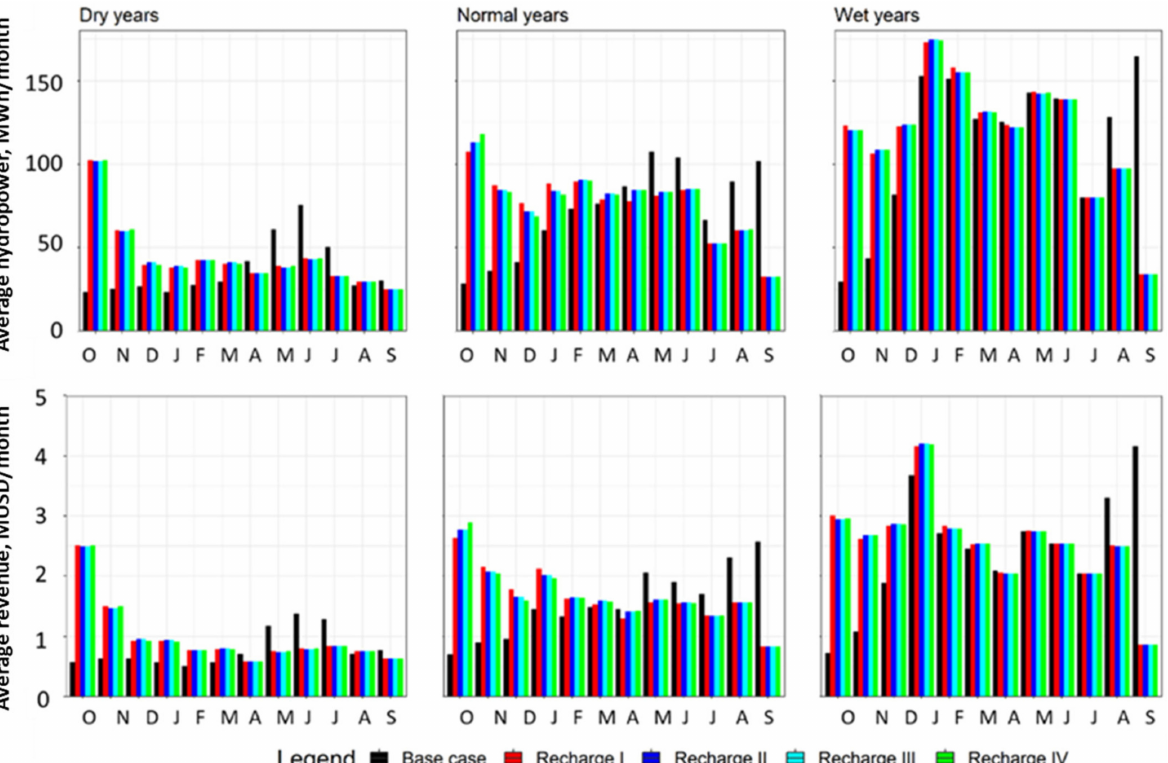
Figure 4. The monthly average hydropower generation ( top ) and revenue ( bottom ) from the Folsom Dam under three recharge scenarios in dry, normal, and wet